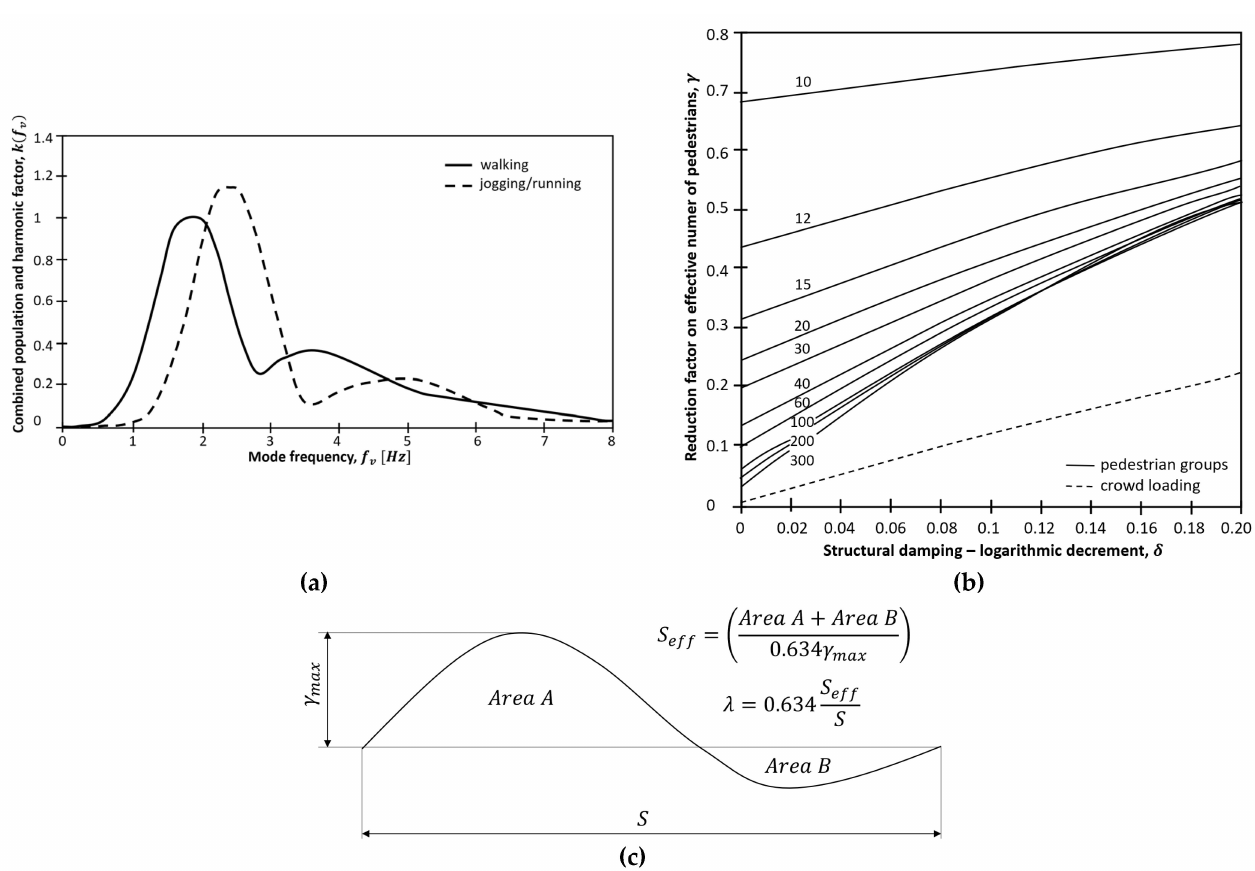
Figure 6. The vertical pulsating force [43]. ( a ) The harmonic factor ( k ) ; ( b ) the reduction factor of the effective number of pedestrians ( γ ) regarding the dependence on damping ( δ ) and the effective span length (S eff m); and ( c ) the effective span length ( S eff )